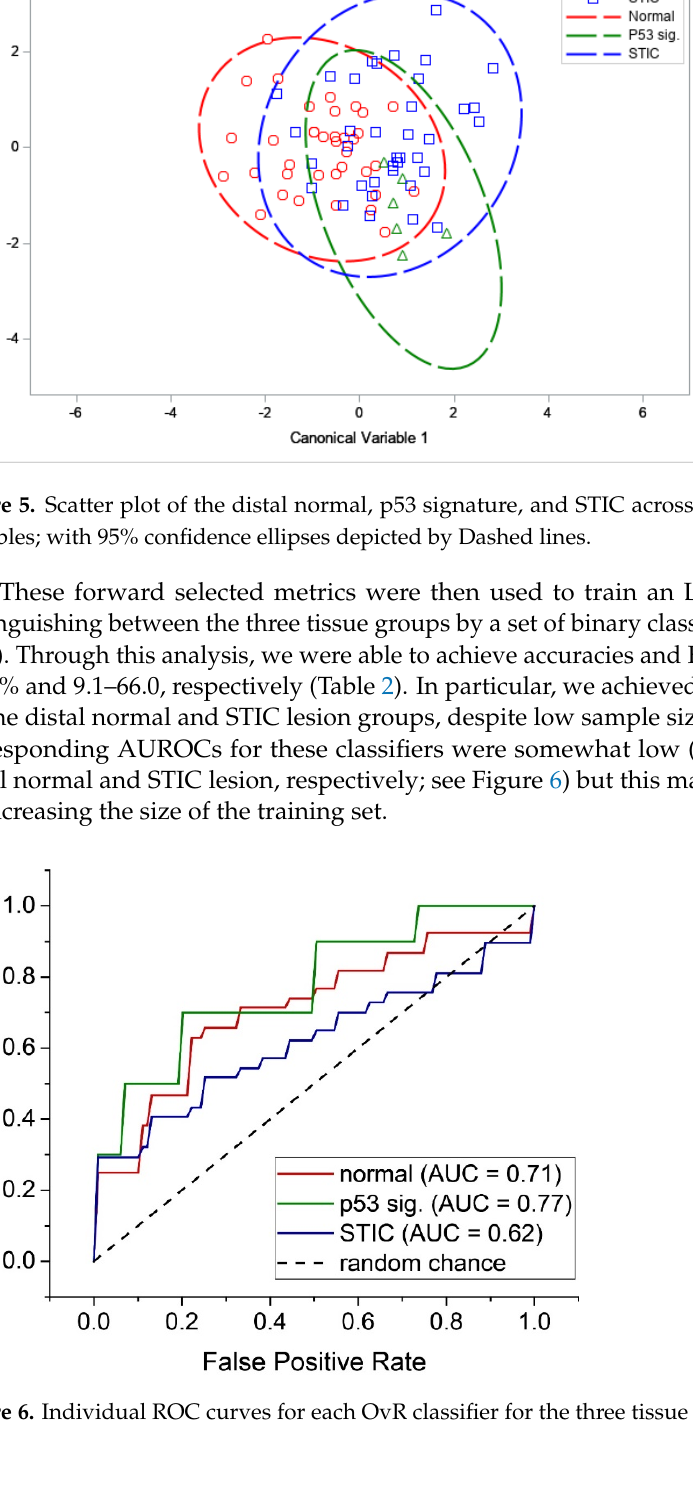
Table 2. The accuracies and F 1 scores for the OvR classifier.